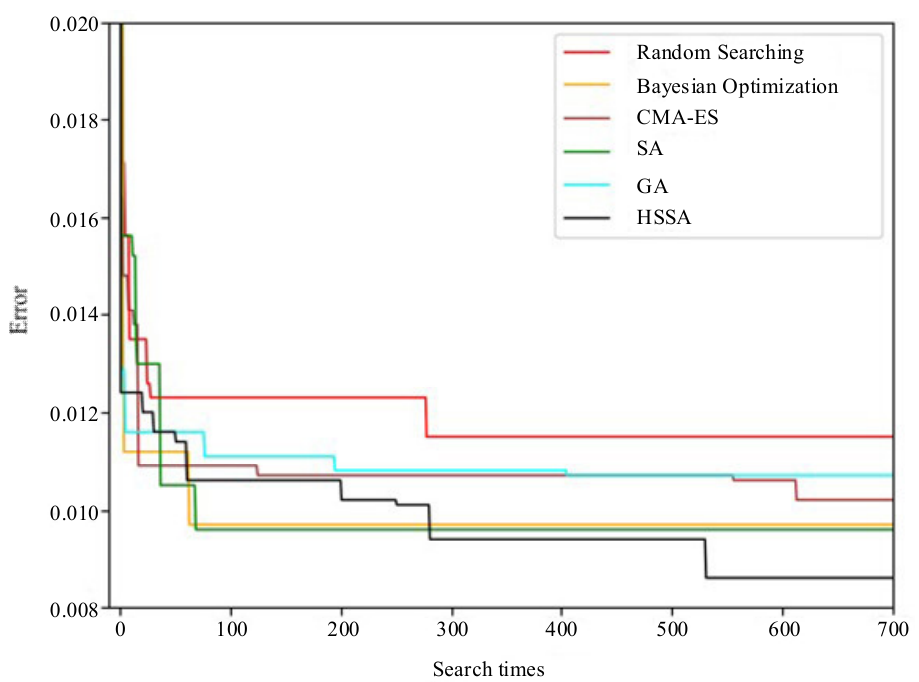
Figure 6. Five Flowers dataset example. Table 5. The range of hyperparameters to be optimized on Five Flowers.